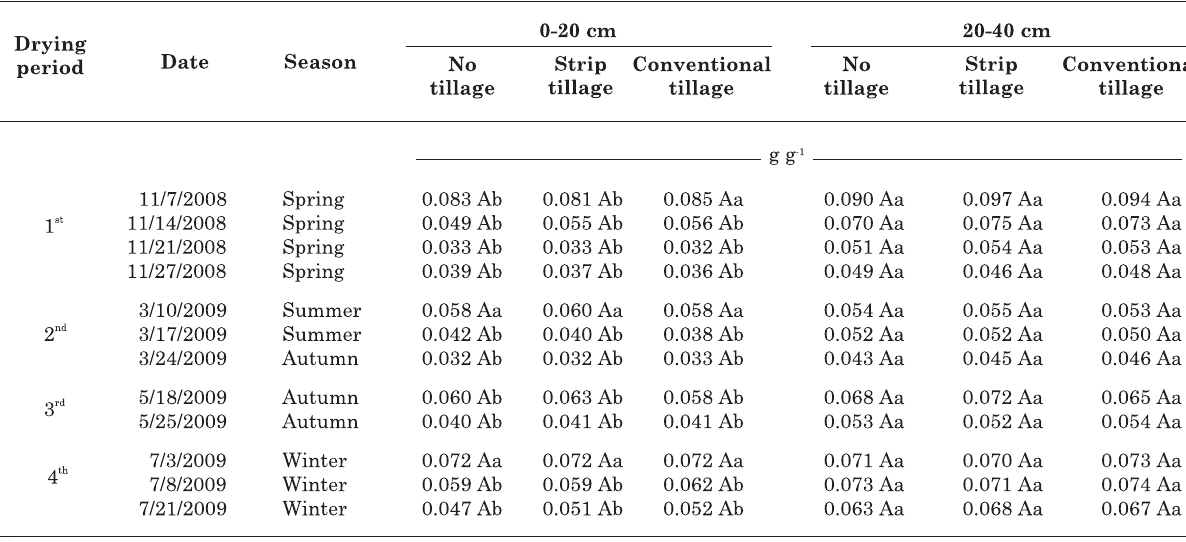
Table 5. Soil water content in four drying periods and four seasons between 2008 and 2009 under soil tillage systems